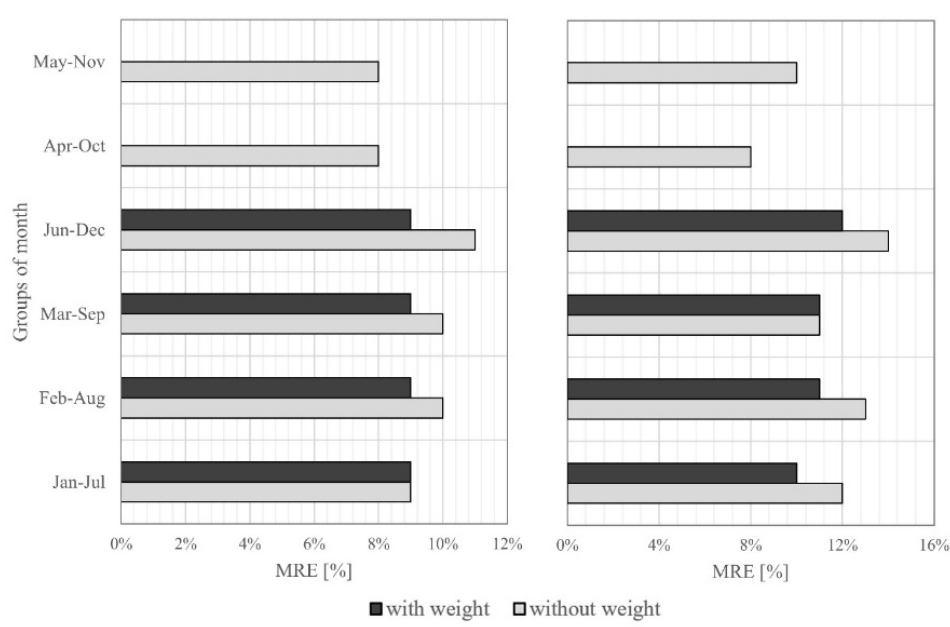
Figure 7. Improvement of the mean absolute error when weighting by 1 of the year by 3 for PM 10 ( left ) and PM 2.5 ( right ). 4